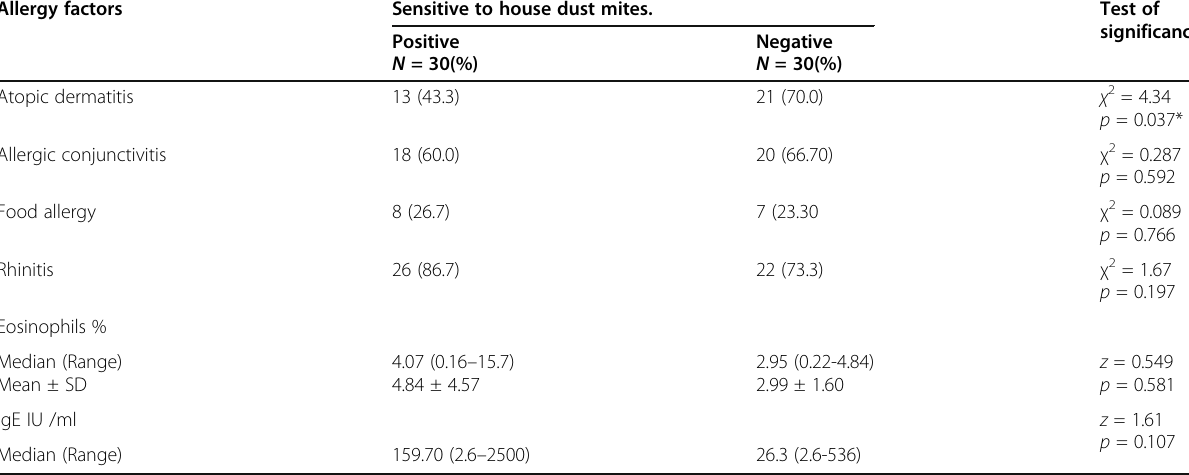
Table 2 Allergic factors distribution among cases according to sensitivity to house dust mites Allergy factors Sensitive to house dust mites.